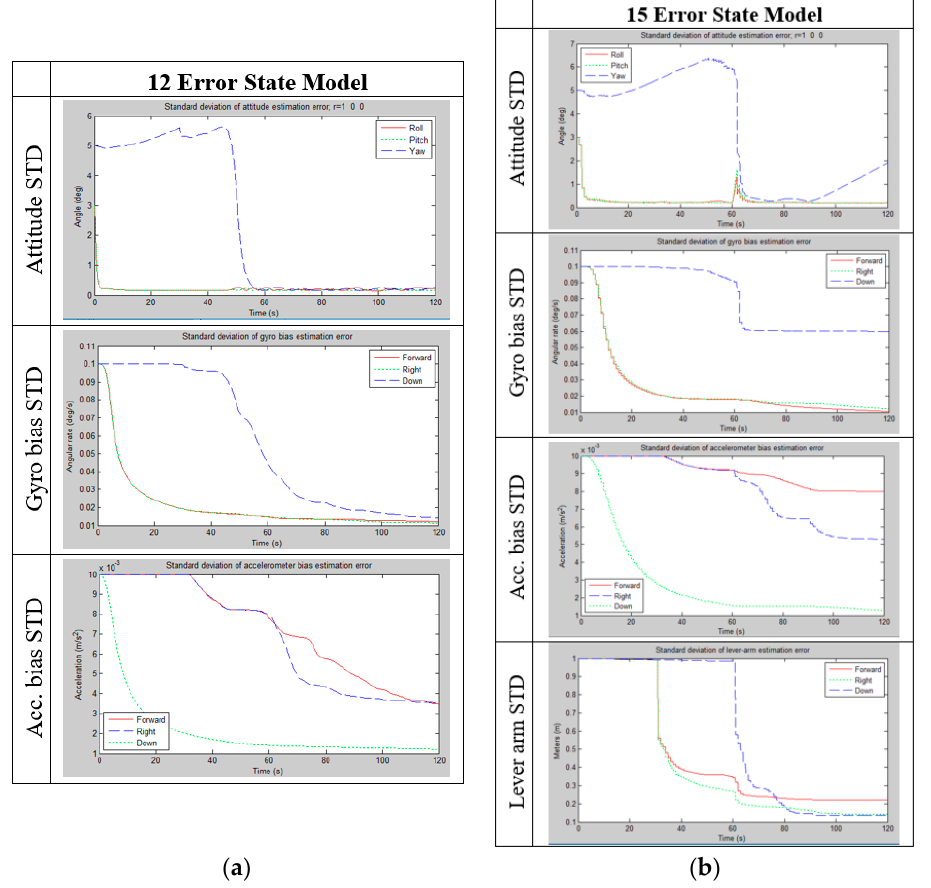
Figure 2. STD results from the software simulation. ( a ) STD values of the 12 error-state model; ( b ) STD values of the 15 error state